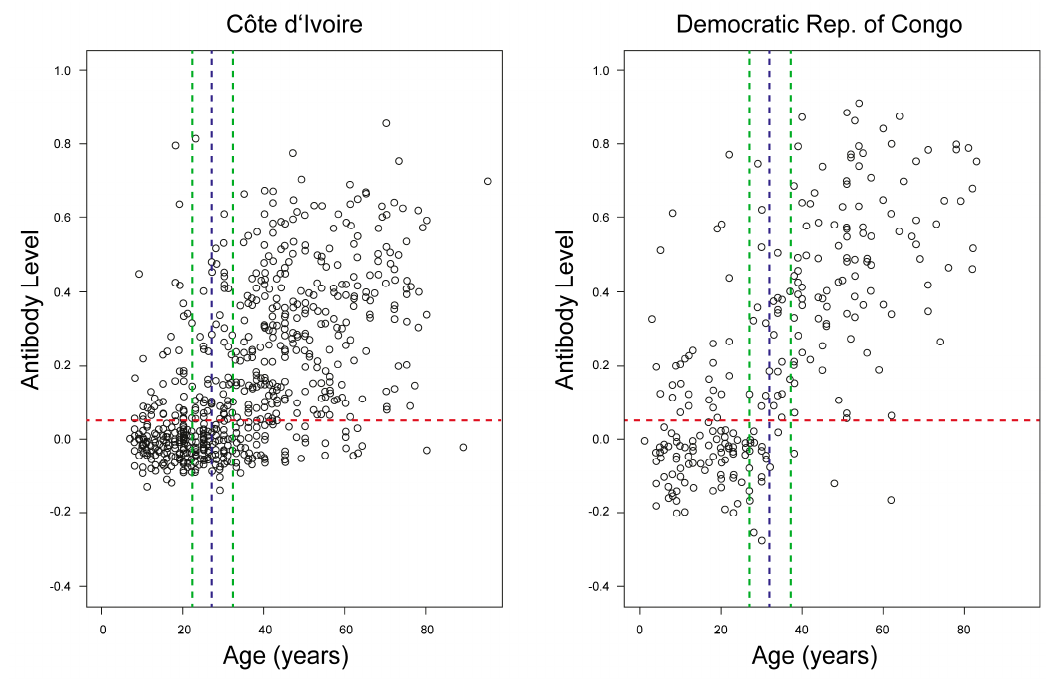
Figure 3. Antibody levels in human participants in CIV and COD. The red horizontal line indicates cut-off value for positive samples. The blue vertical line represents time of vaccination cessation; the green vertical lines indicate the 5-year margins on either side.